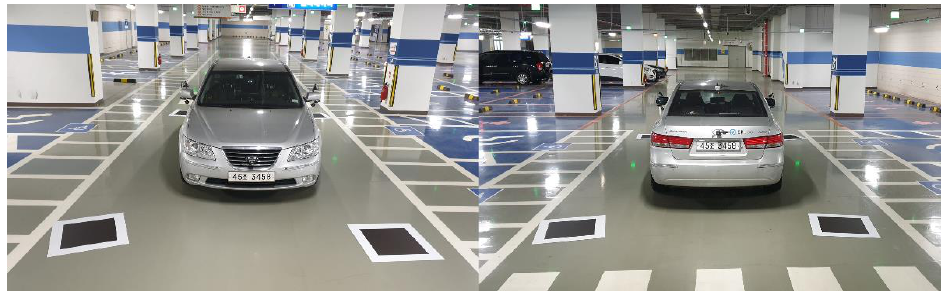
Figure 10. The experimental environment with four randomly placed calibration boards.